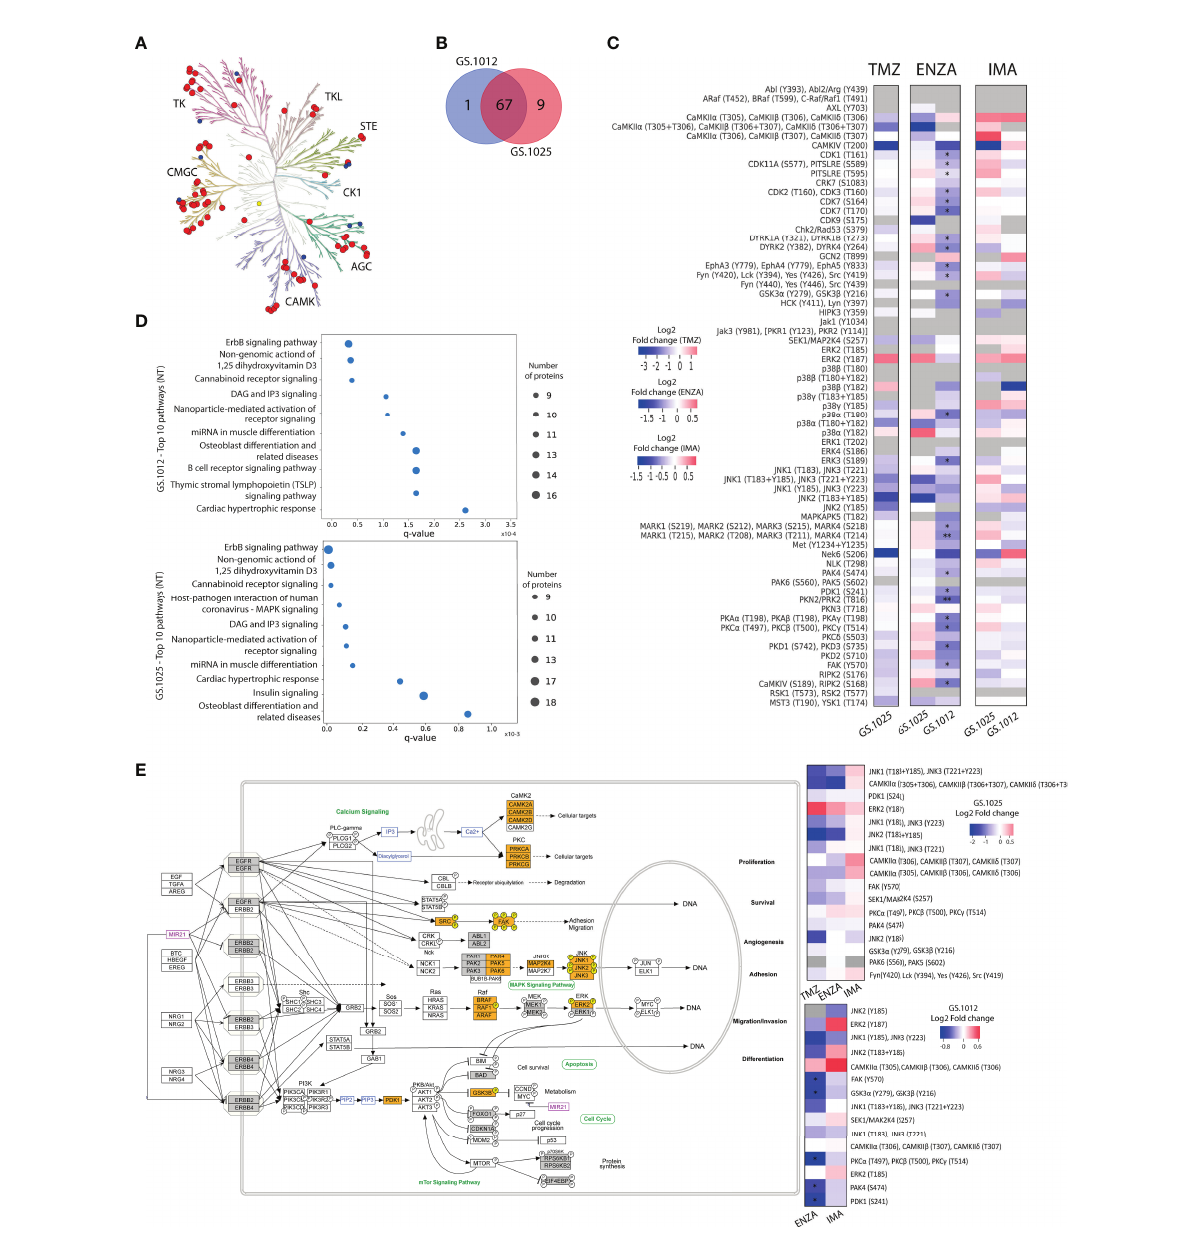
FIGURE 2 Kinase activity andpathway analysisof GS.1012andGS.1025 2D cell cultures. (A) Humankinome treerepresentingthekinasegroupsdetectedwith QuantaKinome ™ . Reddotsrepresentsthe kinasesdetectedinbothGS.1012 andGS.1025samples. Bluedotsrepresentkinasesdetectedonly in GS.1025. Yellowdotsrepresentkinasesdetected only inGS.1012.(ACG:ContainingPKA, PKG, PKCfamilies;CAMK:Calcium/calmodulin-dependentprotein kinase; CK1: Caseinkinase1;CMGC:ContainingCDK,MAPK, GSK3, CLKfamilies;STE:HomologsofyeastSterile 7, Sterile11,Sterile20kinases;TK:Tyrosine kinase;TKL: Tyrosinekinase-like). Illustrationmadewith KinMap(www.kinhub.org/kinmap/). (B) VennDiagramshowingthenumberofcommonand speci fi ckinasesidenti fi ed inGS.1012 andGS.1025. (C) Differential activity analysisin2D cellculturestreatedwithtemozolomide(TMZ),enzastaurin(ENZA), and imatinib(IMA)inGS.1012andGS.1025. Heatmapsshowingthelog2 fold changesofkinaseactivity of thetreatmentscomparedtotheuntreated controls. Grayboxesrepresentkinase activitiesidenti fi edonly inthetreatmentorinthecontrol condition.n=3; *FDRadjusted-p< 0.05; **FDRadjusted- p <0.01. (D) Pathway analysisof2D GS.1012andGS.1025cell cultures. Dotplotshowingthetop10 pathwaysusingthedetectedkinasesinGS.1012 (top) and GS.1025 (bottom)untreatedcells. Thedotsizerepresentsthenumberofkinases detected, while thedistributiononthex-axisindicatetheq-value.The pathwayssourceisWikiPathways. (E) ErbBsignalingpathwayrepresentationaccordingtoWikiPathwaysofkinases detectedin GS.1012andGS.1025.The orangeboxesrepresentthedetected kinaseswithQuantaKinome ™ . Thepathwayhas beenacquiredfromWikiPathways(www.wikipathways.org/ instance/WP673). Thegray boxesrepresentkinases present in theQuantaKinome ™ library butnotdetectedinthestudy.Ontheright, theheatmaps showingthelog2 foldchangesof thekinasesbelongingtotheErbbsignalingpathway in GS.1025 (top)andGS.1012